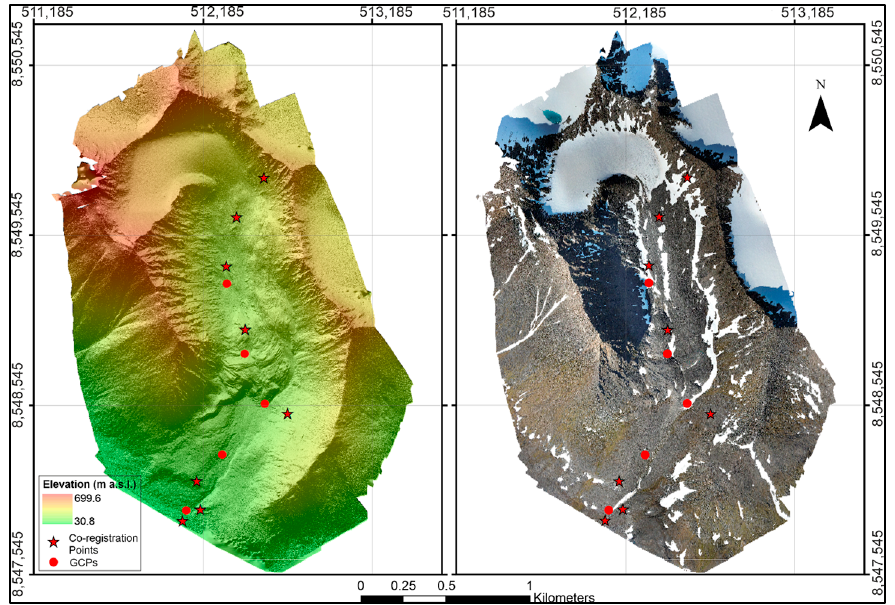
Figure 5. DEM and orthophotomap of the Ariebekken catchment. The final resolution post-pro- cessing was 0.07 m, and it was geo-rectified using five ground control points (red dots) and co- registration points (red